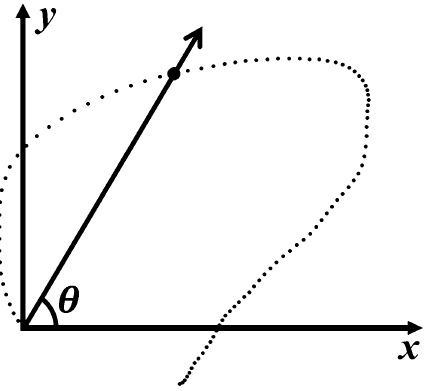
Figure 2. An illustration to show a direction angle of the hyoid bone during swallowing. The direction angle was defined as an angle that characterizes the direction of a straight line for the hyoid bone with respect to a positive horizontal